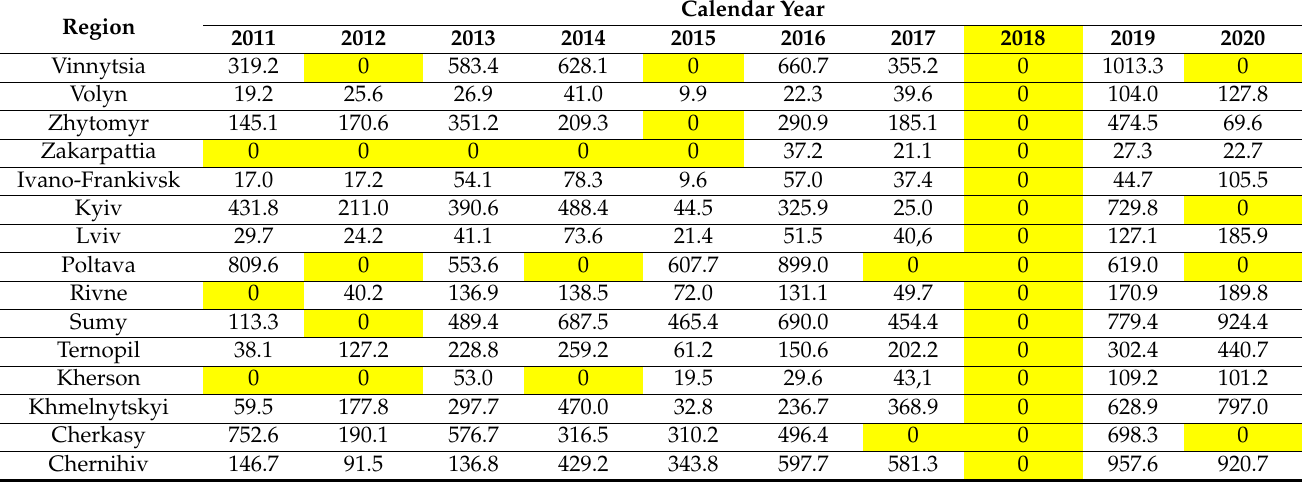
Table 3. Volumes of disposal of corn waste for the production of clean energy, thousand tons.